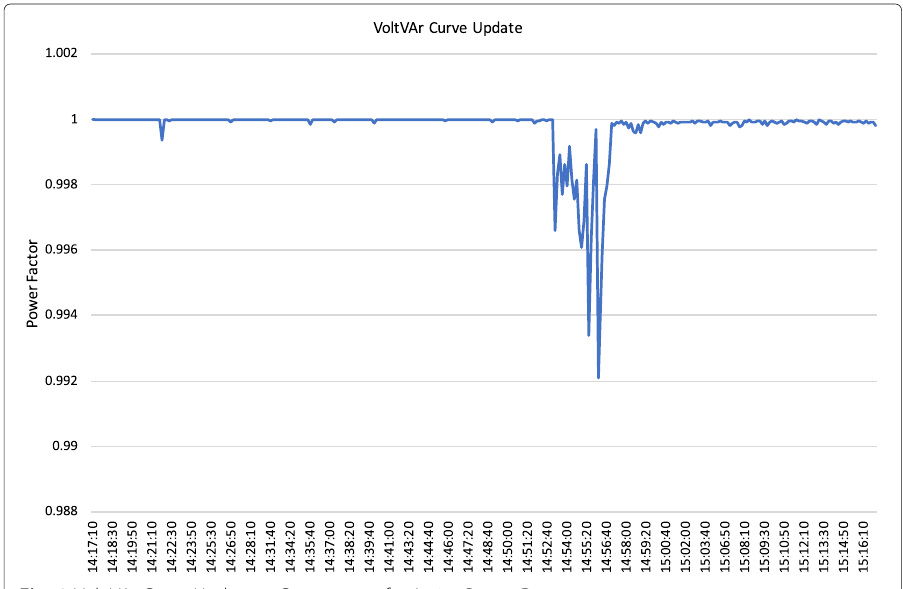
Fig. 6 Volt VAr Curve Update to Compensate for Active Power